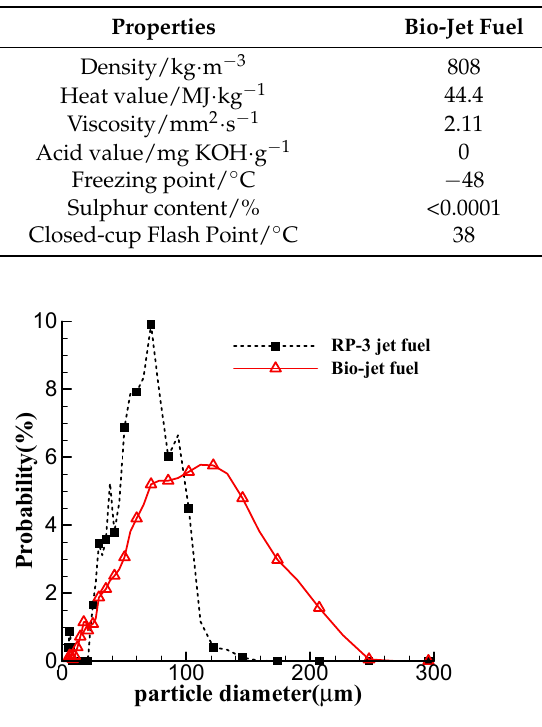
Figure 2. Probability distribution of atomized particle diameter.